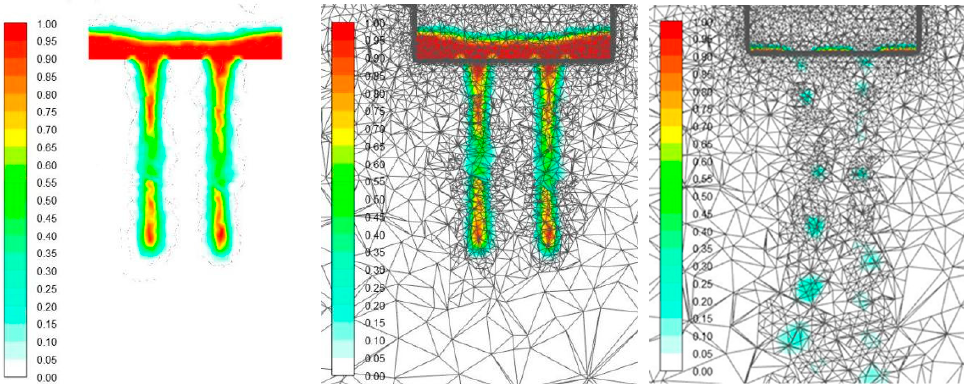
Figure 15. VOF distribution and network of water and air on the cross section inside and under the tank ( t = 0.45 s and t = 1.9 s).